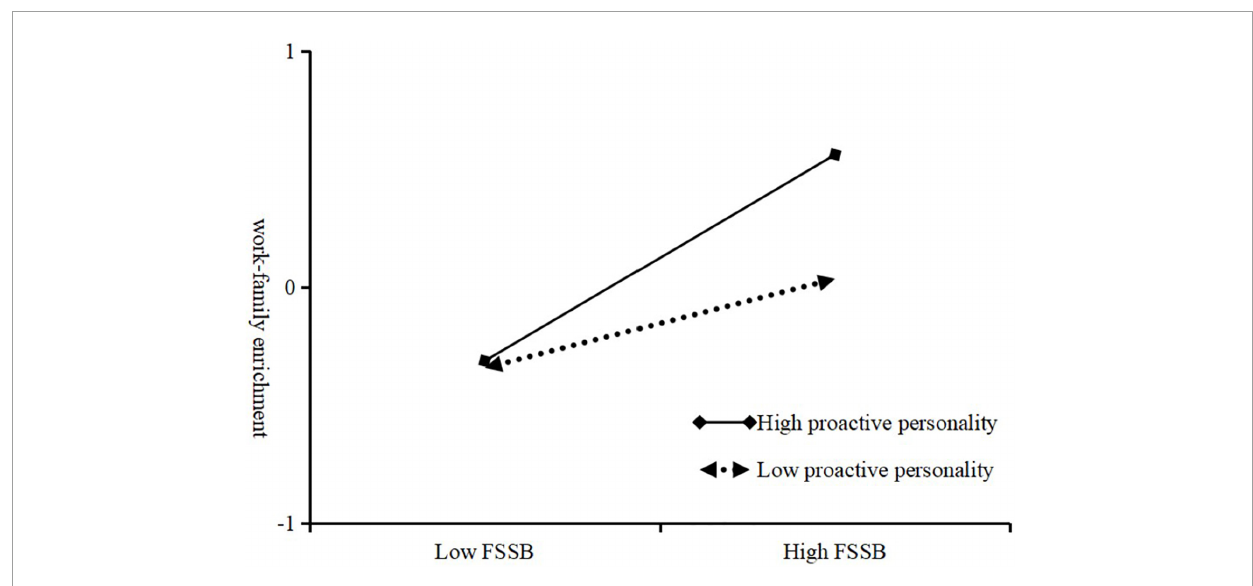
FIGURE2 Analysis of the moderating effect of proactive personality on family supportive leadership and work-family